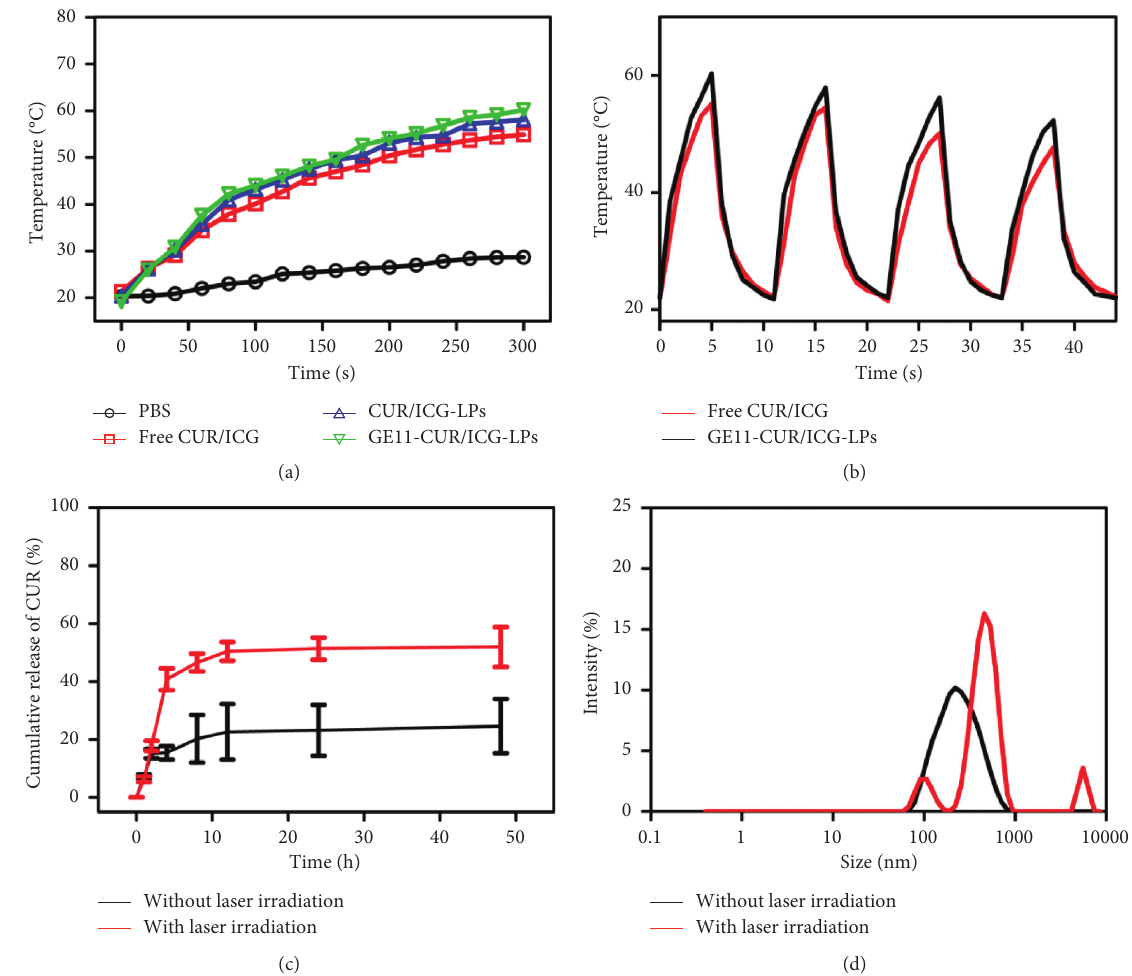
Figure 3: (a) Temperature elevation curves of PBS, free CUR/ICG, CUR/ICG-LPs, and GE11-CUR/ICG-LPs under laser irradiation (1W · cm − 2 , 5min). (b) The temperature change of free CUR/ICG and GE11-CUR/ICG-LPs over four cycles of repeated laser irradiation (1W · cm − 2 , 5min/cycles). (c) In vitro release profiles of CUR from GE11-CUR/ICG-LPs with or without 808nm NIR irradiation at pH 7.4. (d) DLS profiles of GE11-CUR/ICG-LPs before and after NIR irradiation at 808nm for 5